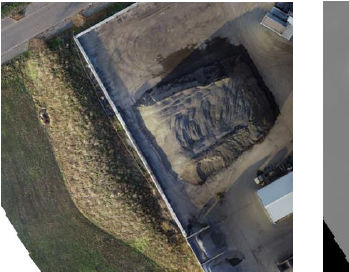
Figure 22 . Selected area from test site A as an example for the ability to distinguish between bulk material heaps and hills that are part of the landscape.